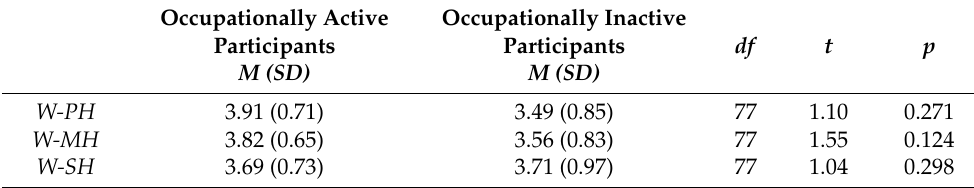
Table 1. Perception of the function of work for health dimensions between occupationally active and inactive